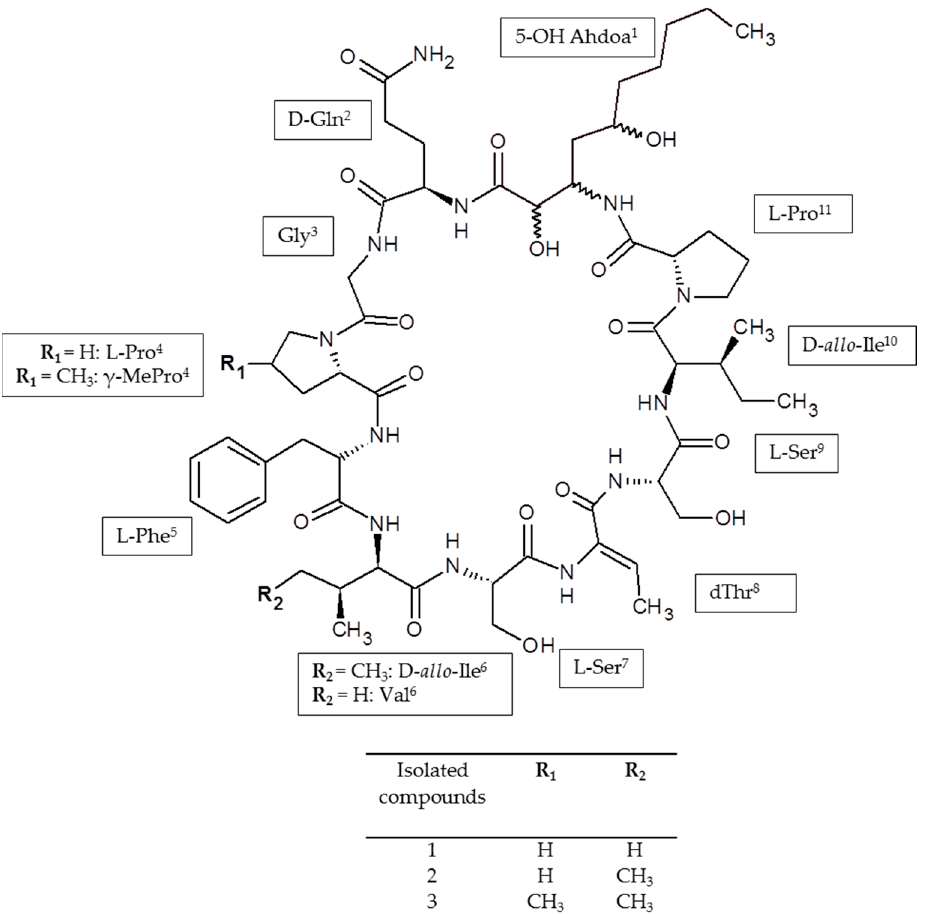
Figure 2. Chemical structures of muscotoxins isolated from the D. muscorum CCALA 125. Ahdoa 1 (3-amino-2-hydroxydecanoic acid), D -Gln 2 ( D -glutamine), Gly 3 (glycine), L -Pro 4,11 ( L -proline), γ -MePro 4 ( γ -methylproline), L -Phe 5 ( L -phenylalanine), D -allo-Ile 6,10 ( D -alloisoleucine), Val 6 (valine), L -Ser 7,9 ( L -serine), dThr 8 (dehydro-threonine).